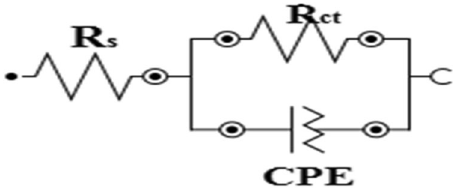
Figure 4. Equivalent circuit employed for the fitting of impedance spectra.